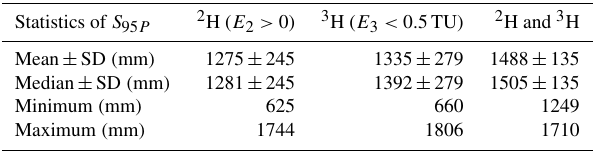
Table 4. Storage estimate S 95P constrained by deuterium or